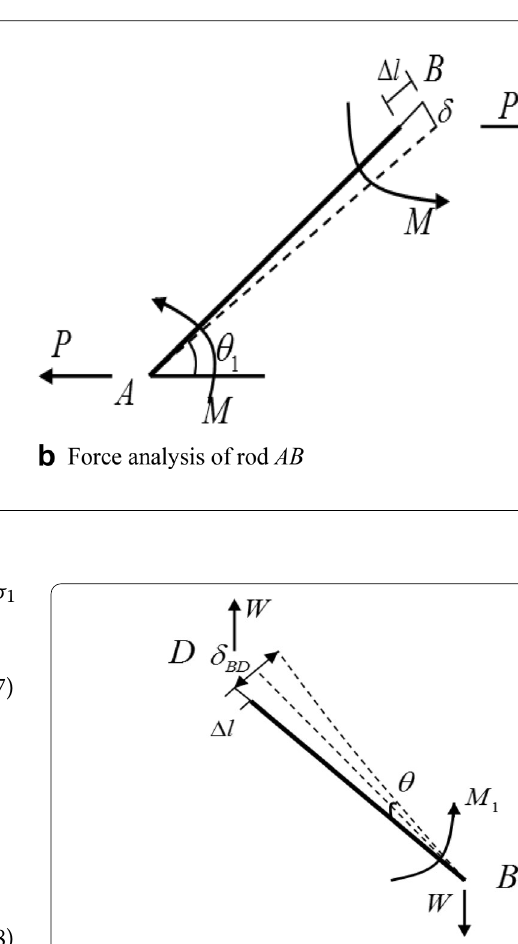
Figure 5 Force analysis of rod